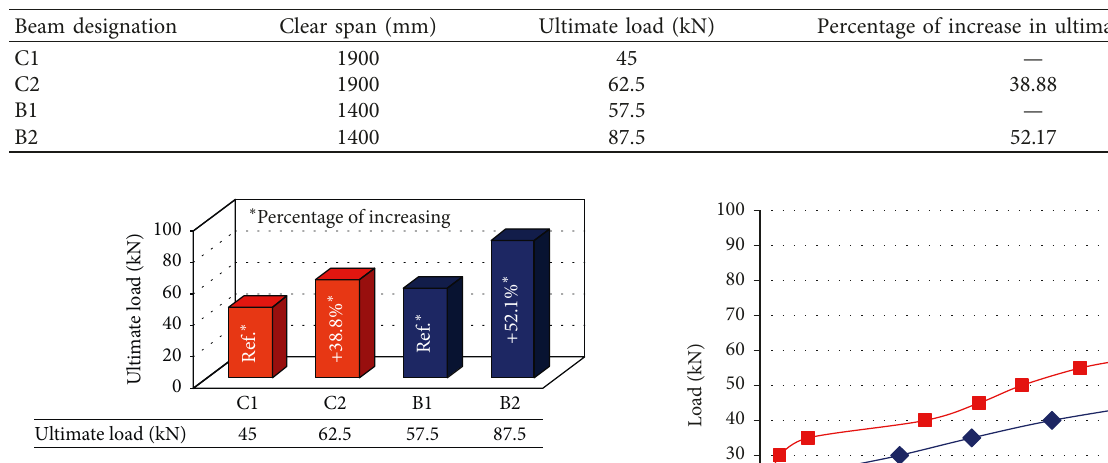
Table 6: Effect of using CFRP on the ultimate load with various clear spans.